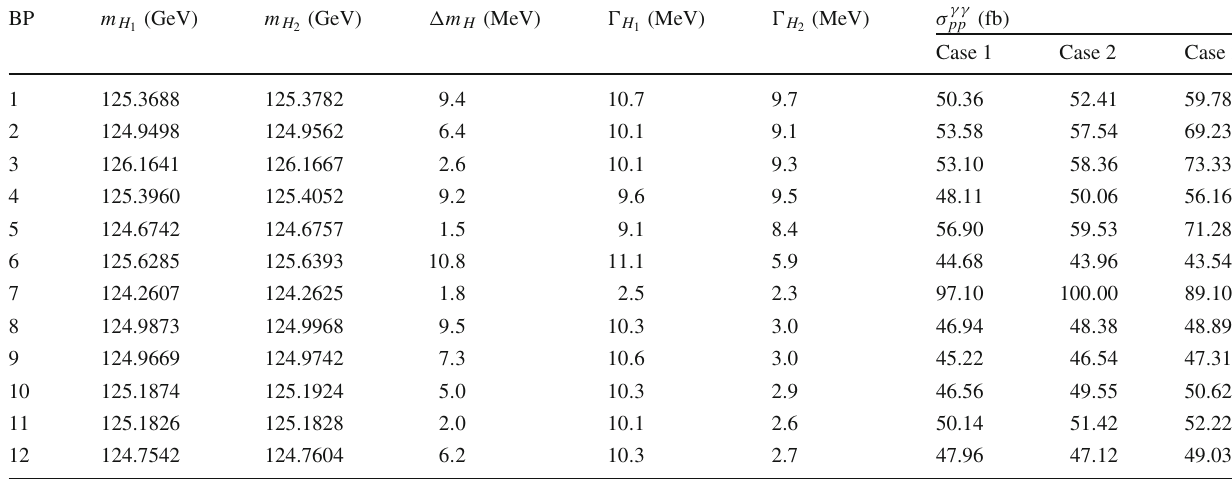
Table 3 The masses and total widths of H 1 and H 2 in the selected BPs. Also listed for each BP is the cross section for the pp → H → γγ process calculated in the three different ways